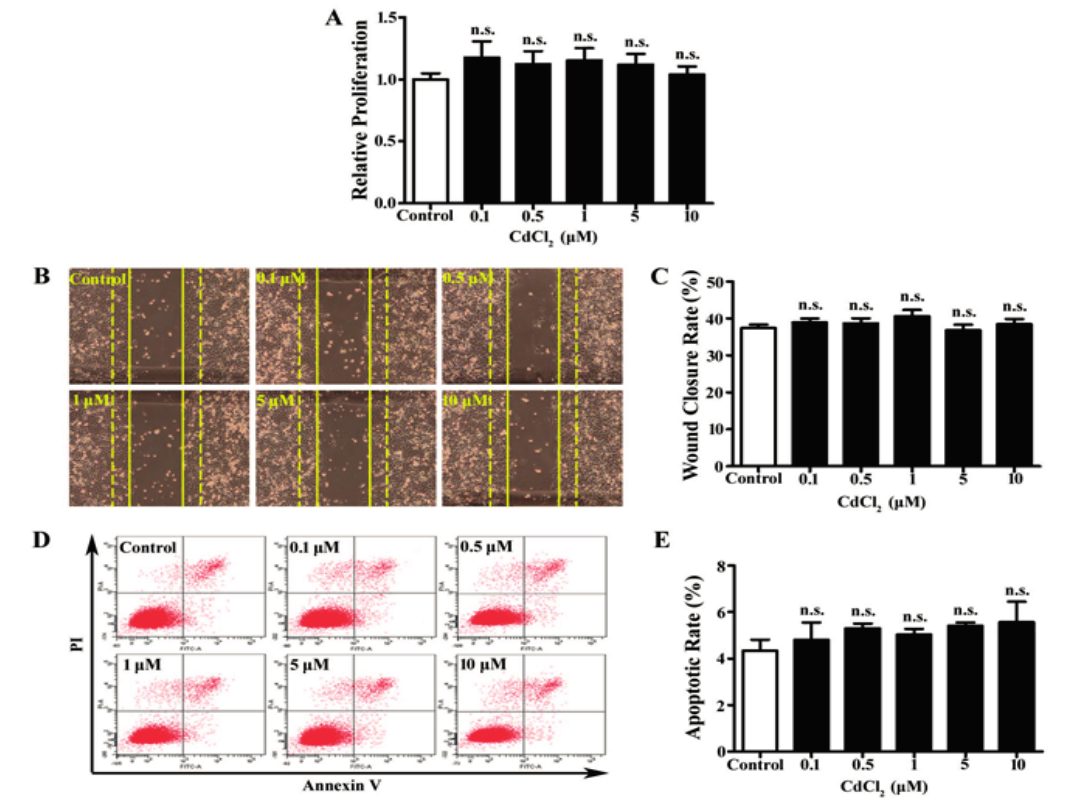
Figure 1. Proliferation, migration, and apoptosis of A549 cells with Cd treatment. ( A ) MTT assay of A549 cells treated with low concentrations (0–10 μ M) of CdCl 2 . n = 6, n.s., non-significant. ( B ) Representative images of wound healing assay of A549 cells with Cd treatment. Dashed lines indicate 0 h and solid lines indicate 12 h. ( C ) Bar graph of wound closure rate of A549 cells. n = 10. ( D ) Representative image of flow cytometry with AnnexinV/PI double-staining for A549 cells treated with Cd. ( E ) Bar graph of A549 cell apoptotic rate following flow cytometry. n =